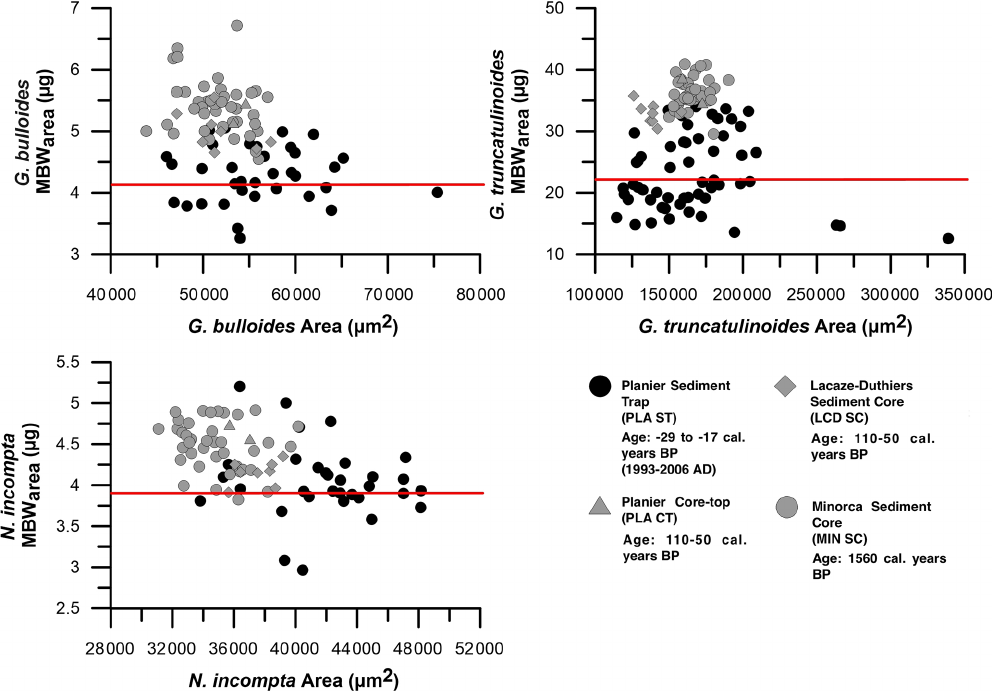
Figure 6. MBW area in µg and area in µm 2 comparison in the sediment trap (PLA ST), Planier core top (PLA CT), and both Lacaze–Duthiers (LCD SC) and Minorca sediment core (MR 3.1.A). Black dots represent data from the sediment trap, while lighter colours represent data from the different seabed sediments. Red lines represent the flux-weighted values from the sediment trap. Note that the age provided represents the dating (see Sect. 3.7) results carried out in specific samples of each site (see Sect.